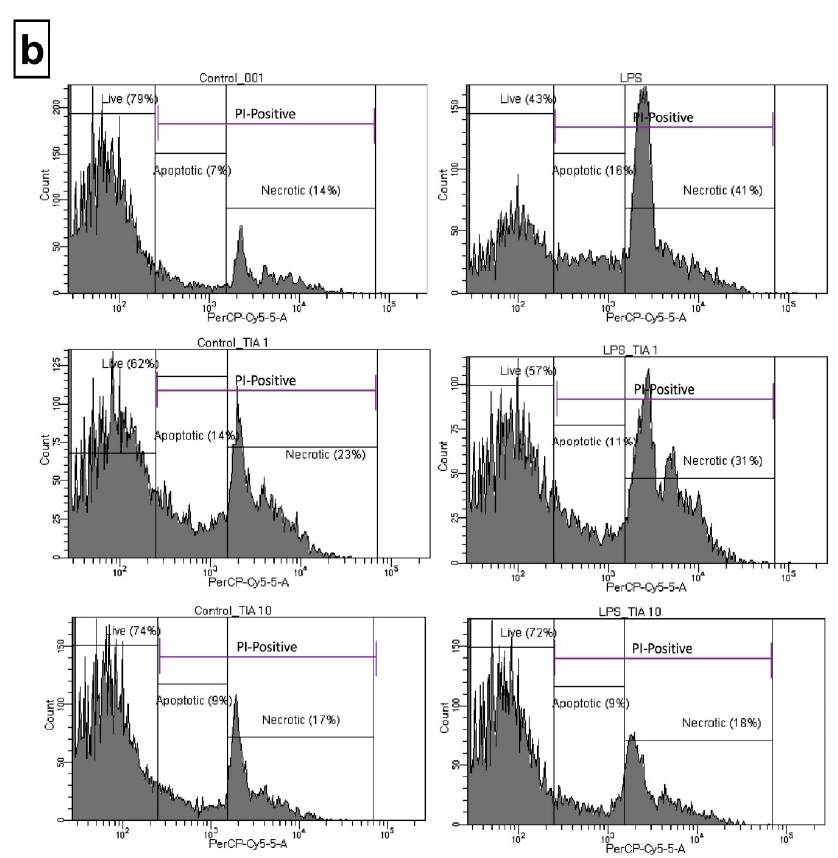
Figure 2. Effect of tianeptine (TIA) on the propidium iodide (PI)-positive cells measured using propidium iodide (PI) staining with flow cytometry analysis in vehicle- and LPS-treated primary microglial cells. ( a ) Illustration of the % of PI-positive cells from all samples ( n = 7–8 in each group); ( b ) representative flow cytometric histograms. Microglial cells were pretreated with tianeptine (TIA; 1 or 10 μ M) for 30 min, and then with lipopolysaccharide (LPS; 100 ng/mL) for 24 h. The data are presented as the mean ± SEM percentage of control (vehicle-treated cells) PI-positive cells, from independent experiments ( n = 7–8 in each group). The results were statistically evaluated using two-way analysis of variance (ANOVA) with a Duncan post-hoc test to assess the differences between the treatment groups. Significant differences from the control group (vehicle-treated cells) are indicated by * p < 0.05; differences between LPS-treated groups and pre-treated with tianeptine and then stimulated with LPS groups are indicated by # p <